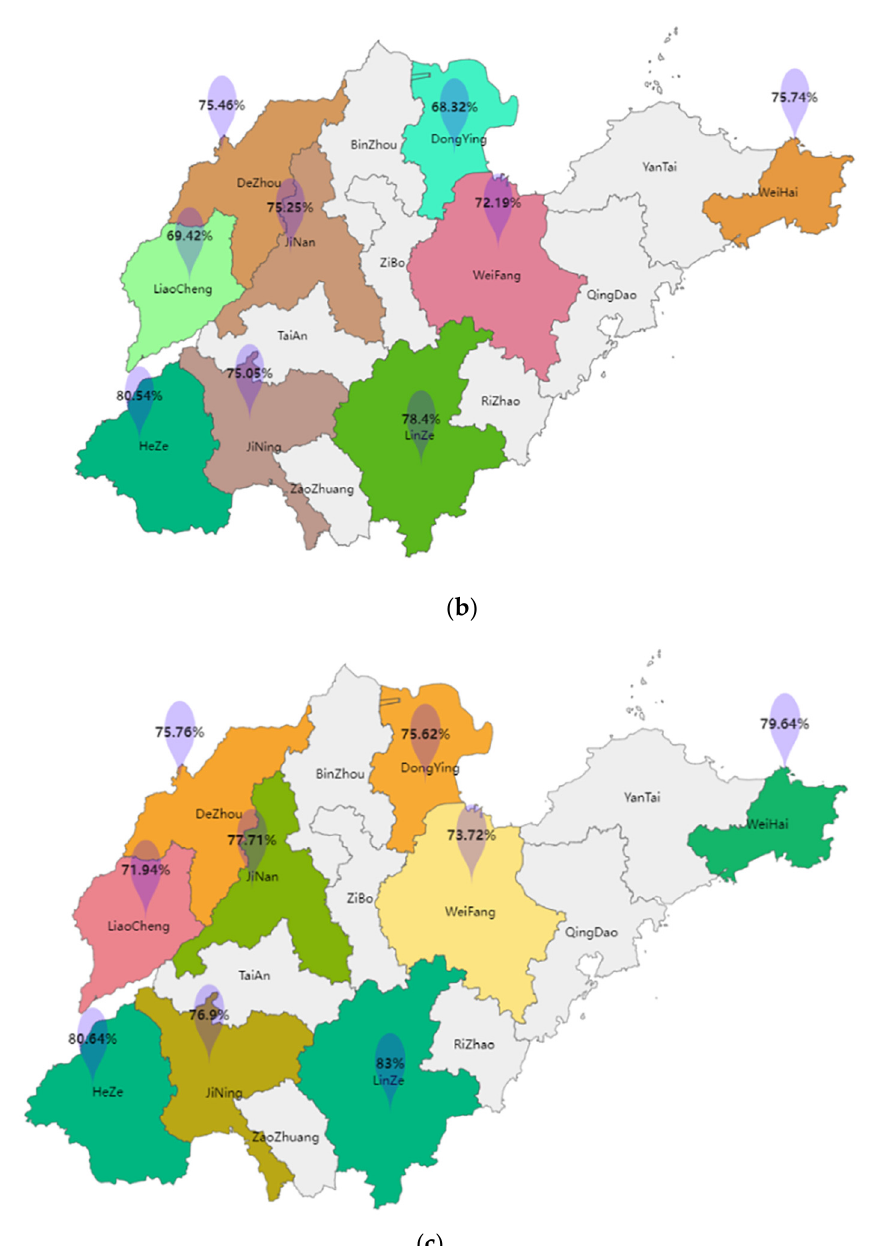
Figure 1. Average scores of physical fitness tests for boys and girls by city level in Shandong Province. ( a ) The average score of all participants in the physical fitness test. ( b ) The average score of the physical fitness test for boys. ( c ) The average score of the physical fitness test for girls.